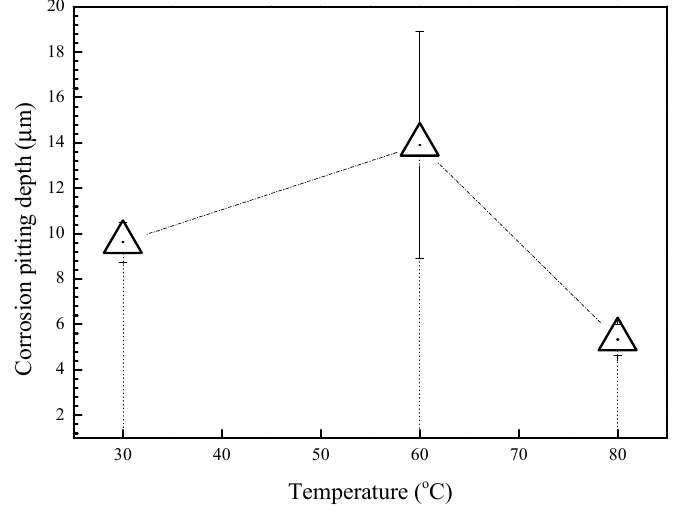
Figure 9. Measured results of corrosion pitting depths of 2A02 Al alloy substrate on removal of corrosion products after corrosion for 200 h at 30 °C, 60 °C and 80 °C. This result corresponds to Figure 8 and was obtained from measured results by LSCM using our own software OLS4000.